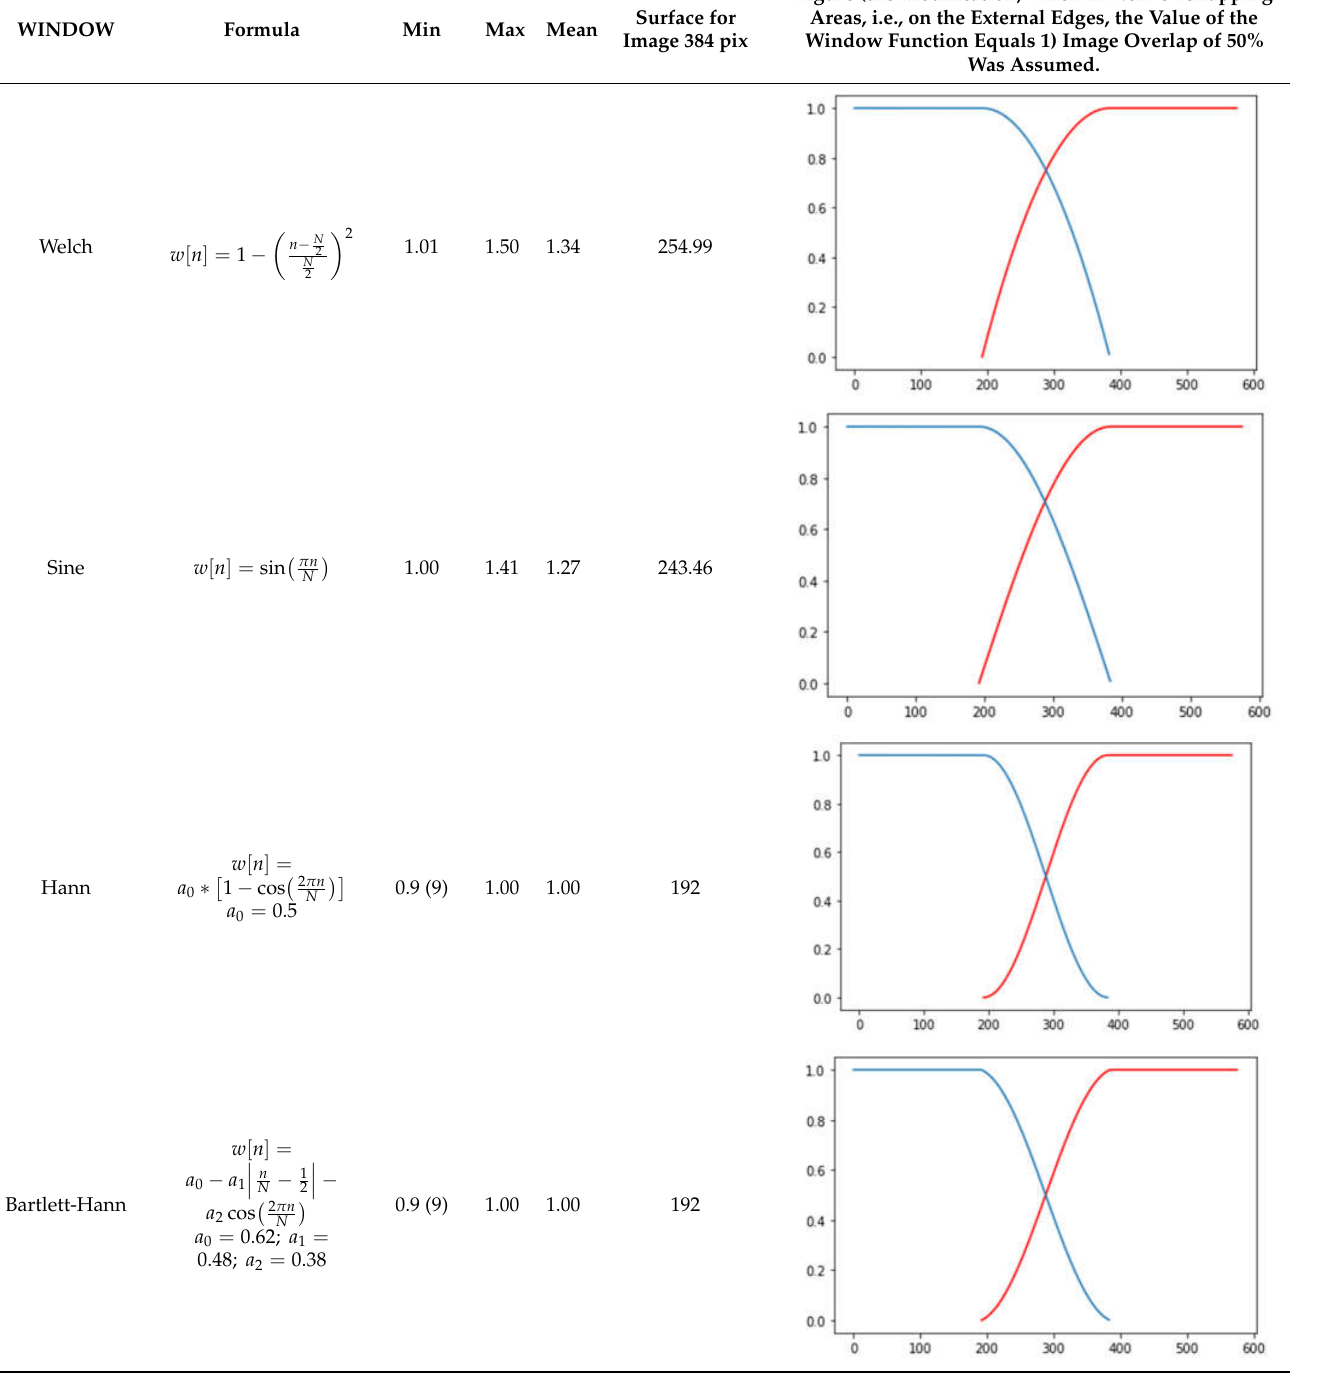
Figure (the Modification, When in Non-Overlapping Areas, i.e., on the External Edges, the Value of the Window Function Equals 1) Image Overlap of 50% Was Assumed.